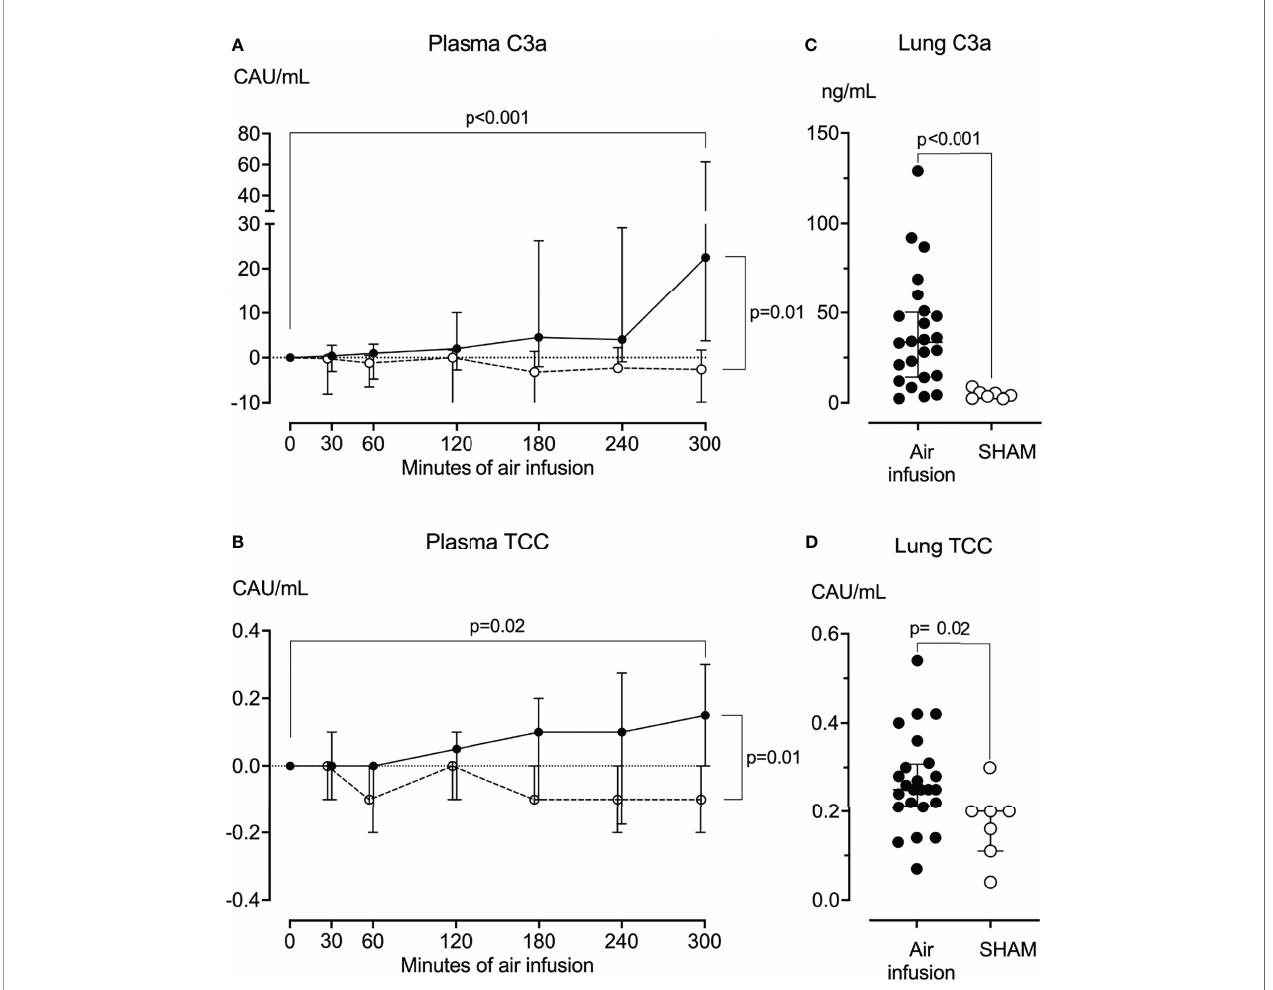
FIGURE 3 | Complement activation products in plasma and lung tissue. (A) Plasma C3a was measured at regular intervals throughout the experiments. C3a increased signi fi cantly from baseline in animals receiving air infusion (solid line) but not in sham animals (dotted line). (B) Plasma TCC measured at regular intervals throughout the experiments increased signi fi cantly from baseline in animals receiving air infusion (solid line) compared to the sham animals (dotted line). (C) In lung tissue sampled post-mortem, C3a was signi fi cantly higher in animals receiving air infusion than in sham animals. (D) In lung tissue sampled post-mortem, TCC was slightly but statistically signi fi cantly higher in animals receiving air infusion than sham animals. Dots in panels (A, B) and horizontal lines in panels (C, D) represent medians. Error bars span the interquartile range. Note Y-axis is split in panel (A) The two-tailed Mann-Whitney test was used between groups, and the Wilcoxon signed ranks test for within-group comparisons. P-values in panels (A, B) are corrected for multiple comparisons using Benjamin and Hochberg ’ s FDR